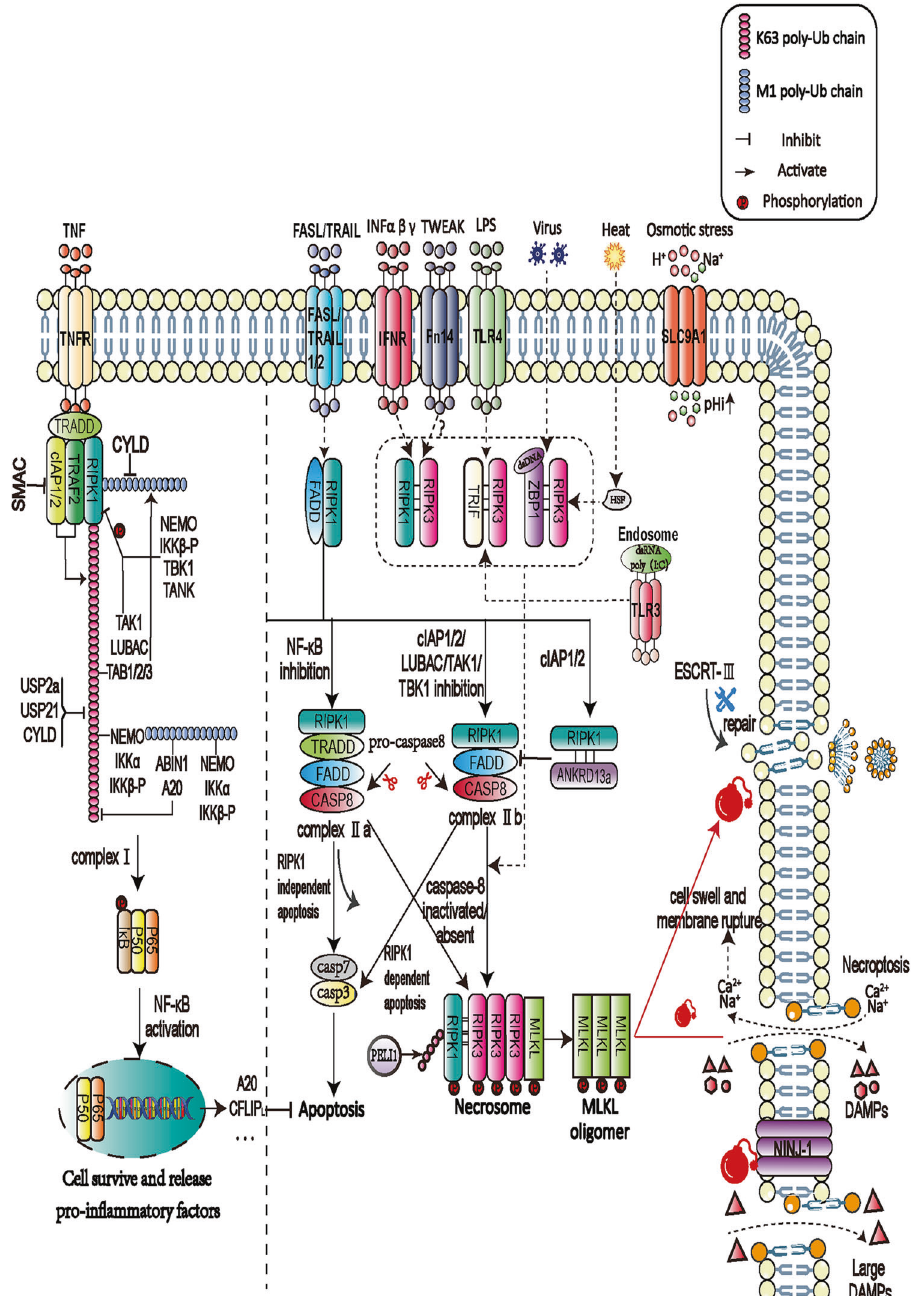
Fig. 2 The molecular mechanisms of necroptosis. Tumor necrosis factor alpha (TNF- α ) binds to TNF receptors, leading to the assembly of complex I, which is mainly composed of TRADD, RIPK1, CIAP1/2, and TRAF2/5. The ubiquitination status of RIPK1 determines the fate of complex I. In most cases, complex I recruits the TAK and IKK complexes, leading to the activation of the NF- κ B pathway, which promotes in fl ammatory factor production and cell survival. When CYLD deubiquitinates RIPK1, A20, USP21, or USP20, both TRADD and RIPK1 detach from complex I and assemble into complex IIa with FADD and caspase-8, leading to apoptosis. RIPK1 can also form complex IIb with FADD and caspase-8. ANKRD13a restricts the interaction of FADD and caspase-8 with ubiquitinated-RIPK1 by binding to the latter via its Ub-interacting motif. When caspase-8 is inhibited or absent, RIPK1 binds to RIPK3 via the RHIM domain, leading to RIPK3 phosphorylation and necrosome formation. An increase in cytoplasmic pH mediated by the activity of the Na + /H + exchanger SLC9A1 and osmotic stress promotes necroptosis by directly stimulating the kinase activity of RIPK3. Heat stress activates ZBP1 through the transcription factor HSF1, which binds to and phosphorylates RIPK3, leading to the induction of pyroptosis through the MLKL pathway. Subsequently, MLKL is phosphorylated and oligomerized, translocates to the cell membrane, and promotes membrane rupture. Multiple death receptors can mediate the occurrence of necroptosis (see Table 1). NINJ1 is only partially involved in the release of Lactate Dehydrogenase (LDH, a standard measure of PMR) during MLKL-dependent necroptosis. In addition, ESCRT-III can repair plasma membrane rupture downstream of MLKL.